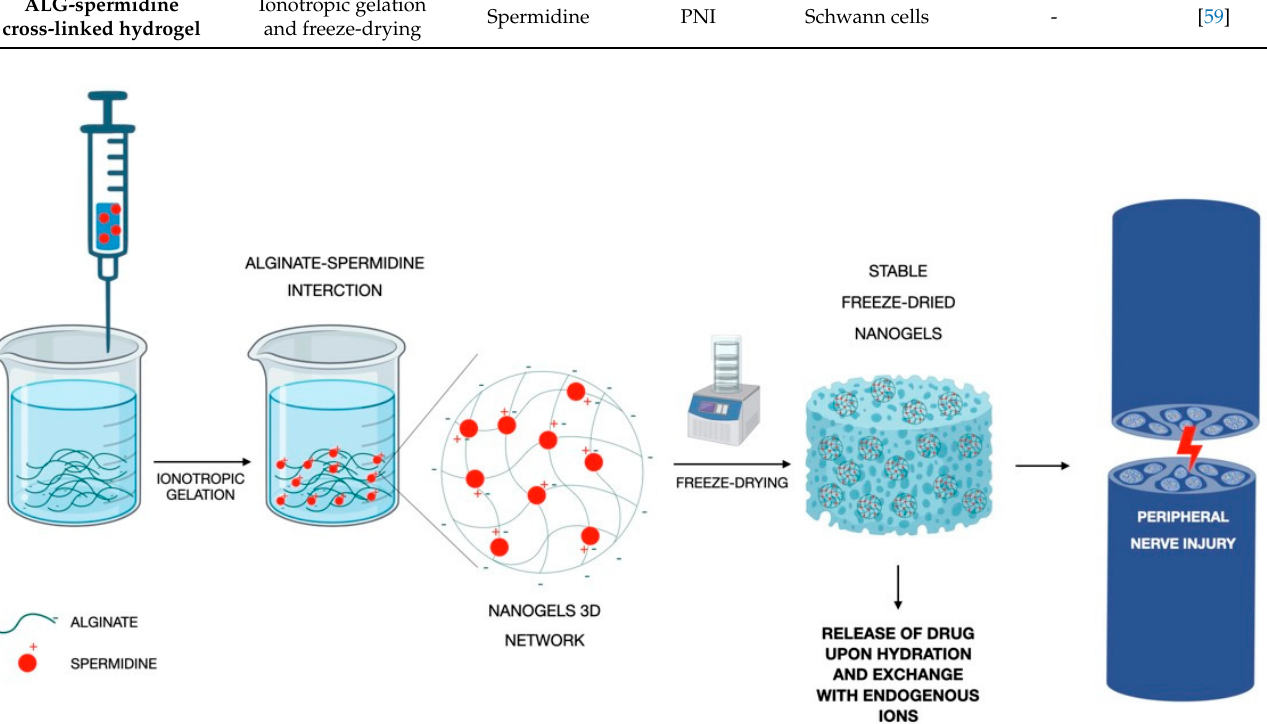
Figure 5. Graphical description of the development of SP-ALG cross-linked nanogels modified by Valentino et al. [59].